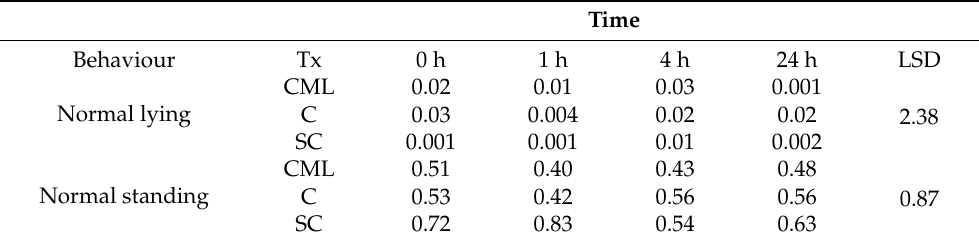
Table 6. Table of back-transformed means for significant treatment x time interactions with the least significant difference presented. Treatment groups are as follows: castration + analgesia (CML), castration (C), and sham control (SC).